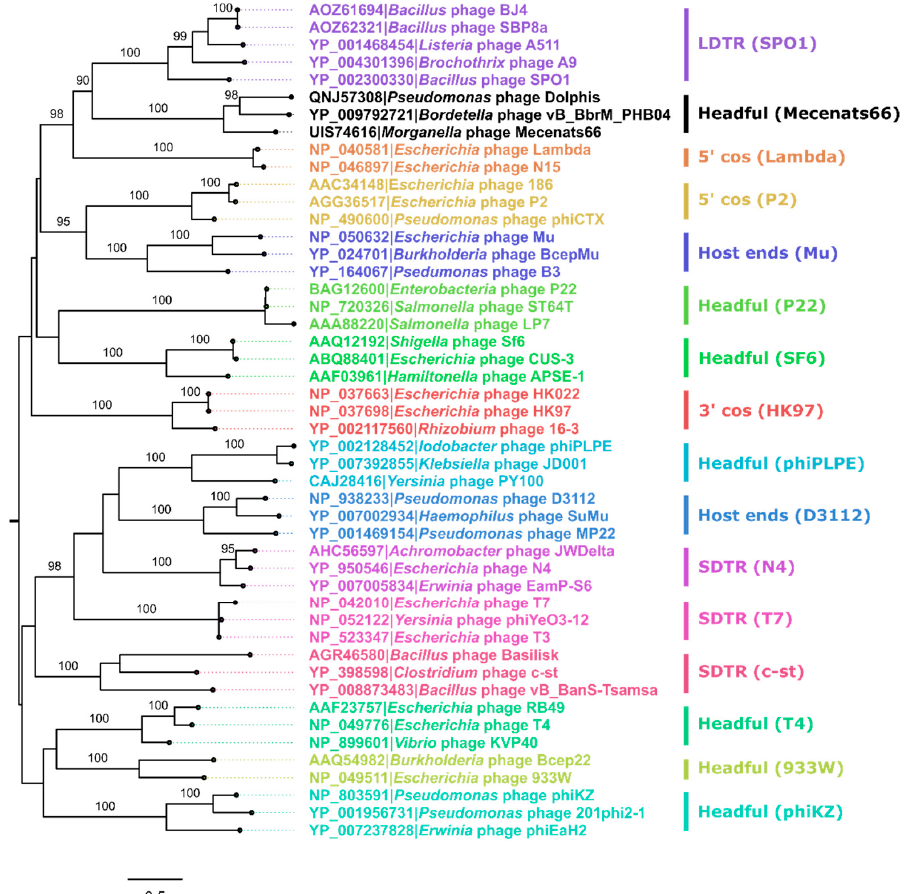
Figure 4. The maximum-likelihood tree of terminase/terminase large subunit (TerL) amino acid sequences for the prediction of the phage Mecenats66 packaging strategy. Input alignment had 48 sequences with 1539 columns, 1482 distinct patterns, 996 parsimony-informative, 346 singleton sites, and 197 constant sites. The tree was built using VT + F + R4 as the best-fit substitution model. Near zero-length branches were collapsed into polytomies. The tree shown is midpoint rooted. Tip labels are colored based on the distinct packaging strategies the phages seen in the tree employ (experimentally verified for most of the phages represented in the tree [34]). The percentage of replicate trees in which the associated sequences clustered together in the ultrafast bootstrap (UFBoot; 1000 replicates) is shown next to the branches for branches having a UFBoot support higher or equal to 95% (except for the MRCA node of the SPO1 type and Mecenats66 type TerL/terminase sequence clades for which a UFBoot of 90% is also shown). The tree is drawn to scale, and branch lengths represent the number of amino acid substitutions per site. Tip labels correspond to the phages from which the respective terminase/TerL amino acid sequences were derived and are in the format of “Protein accession|Phage”. Colored bars next to the labels indicate evolutionary distinct TerL clades, which correspond to different packaging strategies (LDTR stands for long direct terminal repeats, SDTR—short direct terminal